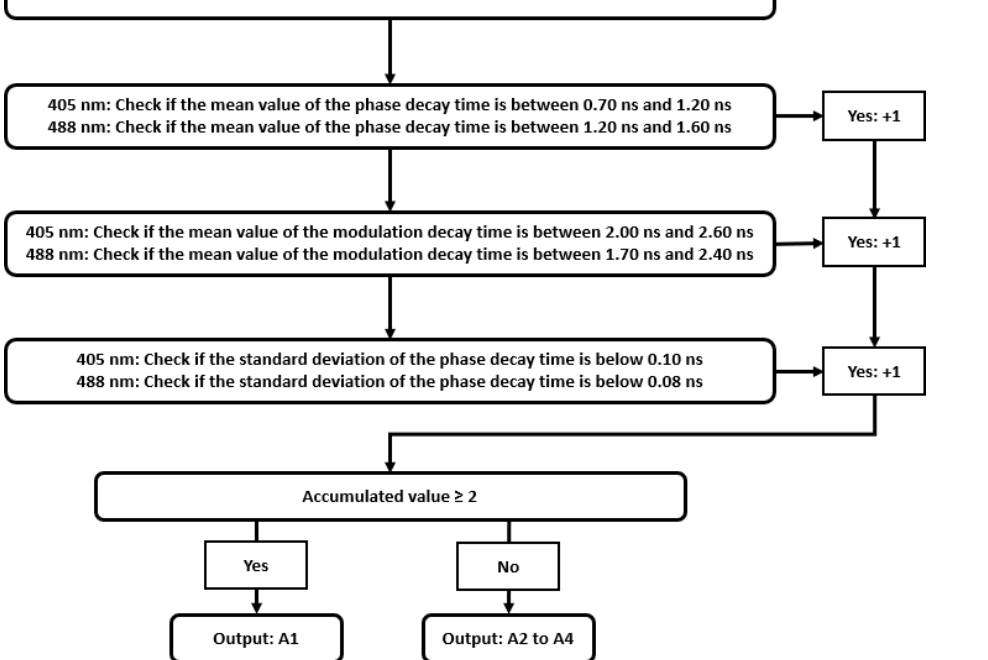
Figure 6. Flow chart of the evaluation decision tree to identify the wood